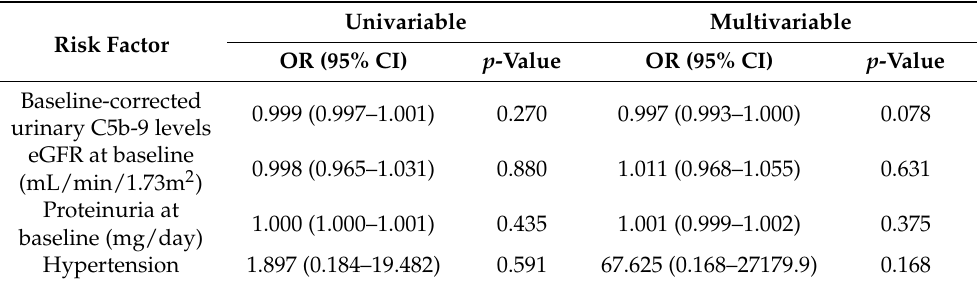
Table 3. Univariable and multivariable logistic regression analyses of independent prognostic factors for treatment response.